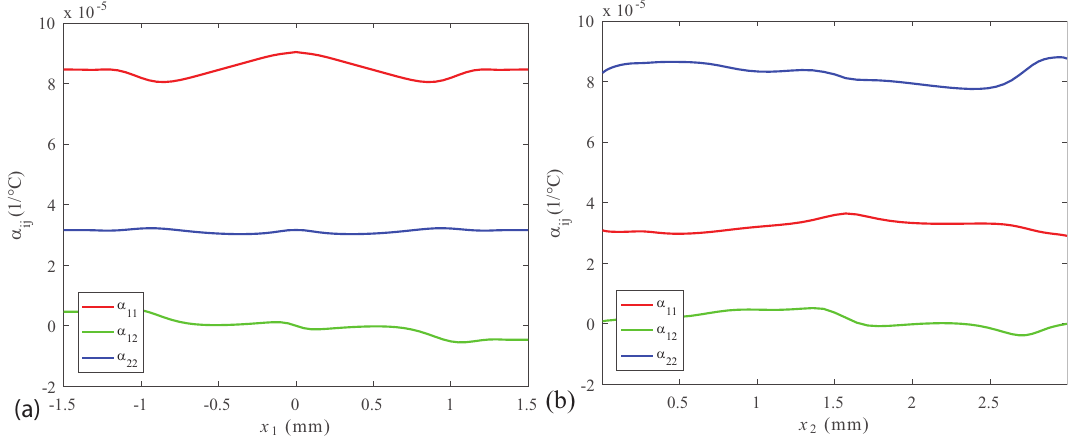
(cid:68) (cid:69) Figure 6. Components of α ij from using the IRD model with C I = 10 − 2 ( a ) as a function of x 1 at the nozzle exit, and ( b ) as a function of x 2 at the end of the